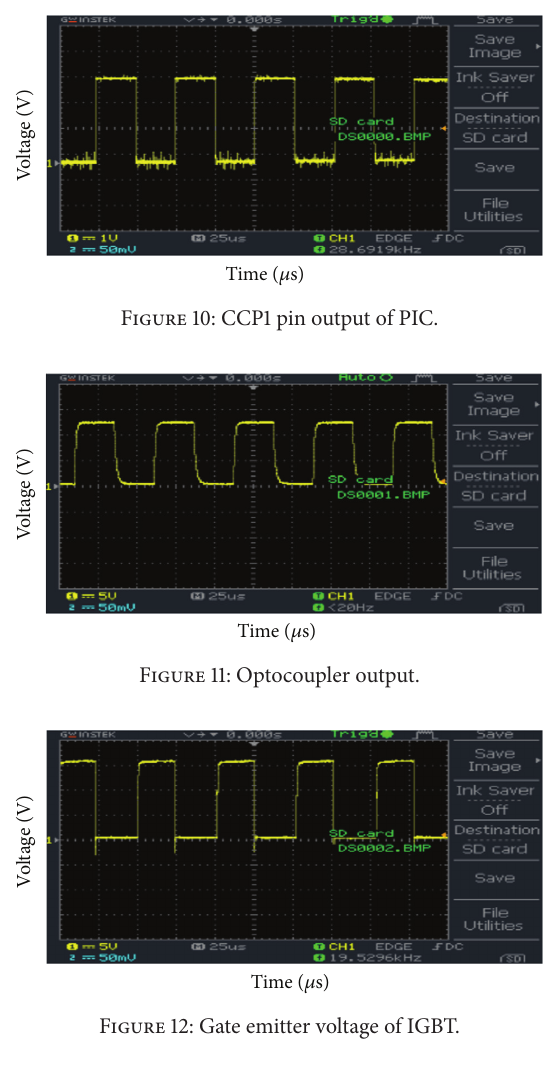
Figure 13: Voltages across 50 ohm resistor with snubber.